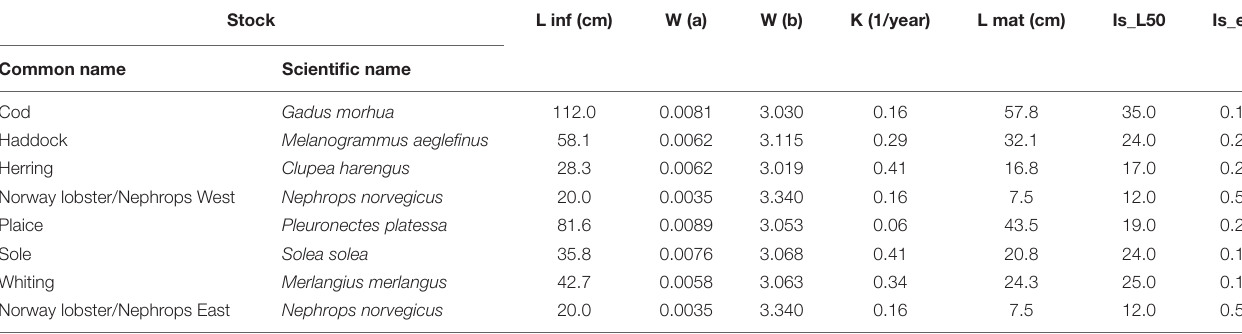
TABLE 1 | Irish Sea model stocks.